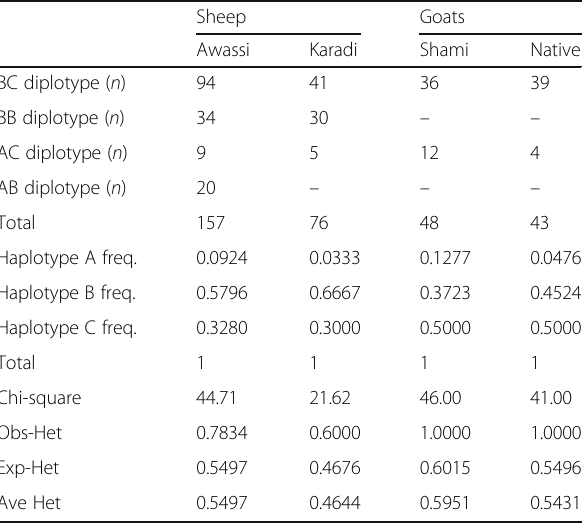
diplotypes were higher than their expected values. This refers to the high level of genetic variability in the stud- ied populations. Table 2 Diplotype distribution and haplotype frequencies at the 262-bp GHRL locus in the Awassi and Karadi sheep and Shami and Iraqi Native goat breeds. The number of significant ( P < 0.05) linkage disequilibria (LD) = 0. All chi-square tests